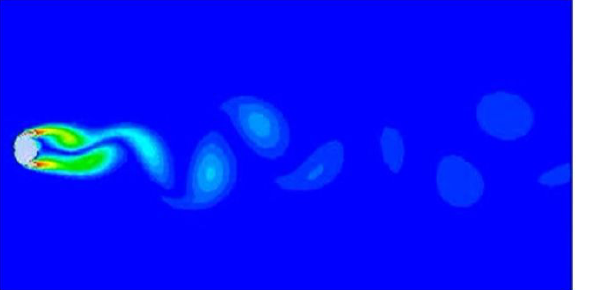
Figure 9: Instantaneous vorticity field at f v = 0.5 f s , crossflow vibration